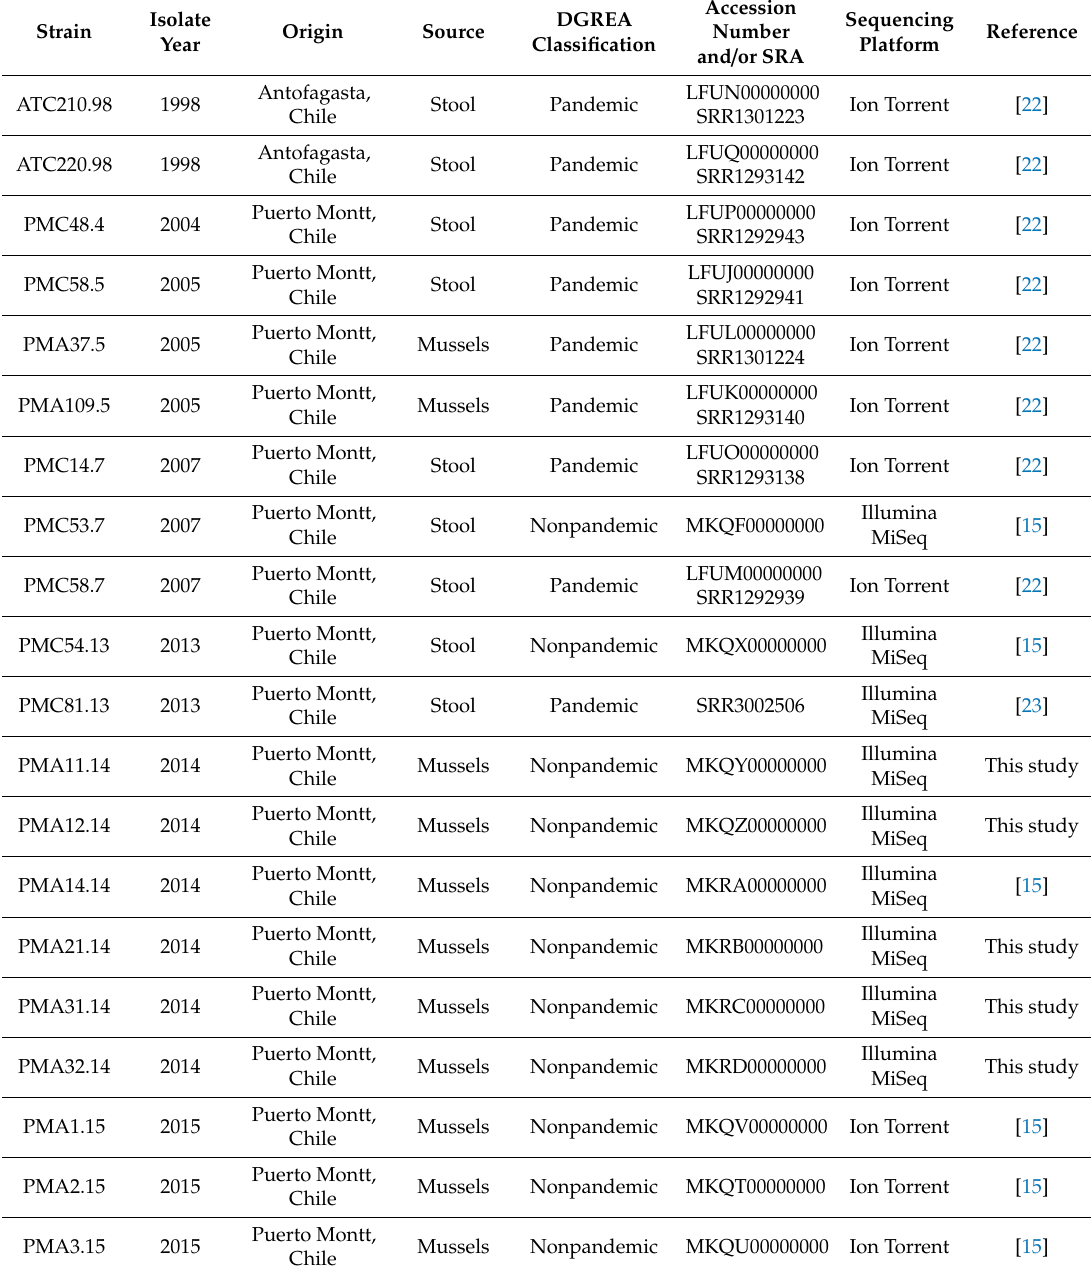
Table 1. Chilean V. parahaemolyticus strains analyzed in this